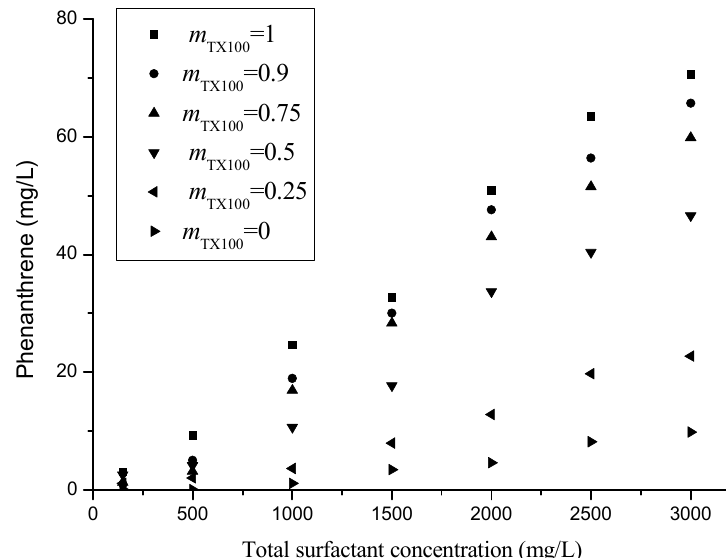
Figure 2. Solubilization of phenanthrene with total surfactant concentration at CMC, 500, 1000, 1500, 2000, 2500 and 3000mg / L, and with mass ratios of TX100 and rhamnolipids at 1:0; 9:1; 3:1; 1:1; 1:3; and 0:1, respectively ( m TX100 : the bulk mass fraction of TX100 in TX100 and rhamnolipids mixture).